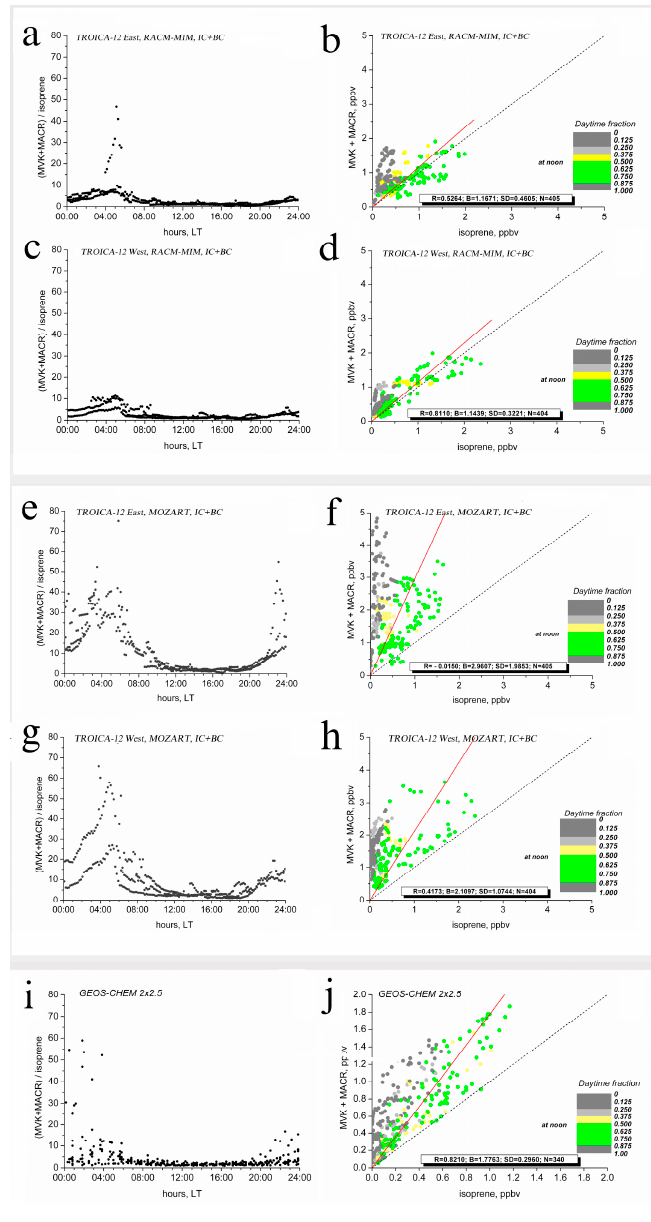
Figure 8. The diurnal variation of the ratio simulated using RACM-MIM and MOZART gas-phase mechanisms of the WRF-CHEM model and the CIS mechanism of the GEOS-CHEM model; ( a , e )—TROICA-12 East and ( c , g )—TROICA-12 West. Due to a rough resolution grid of 2 × 2.5 ◦